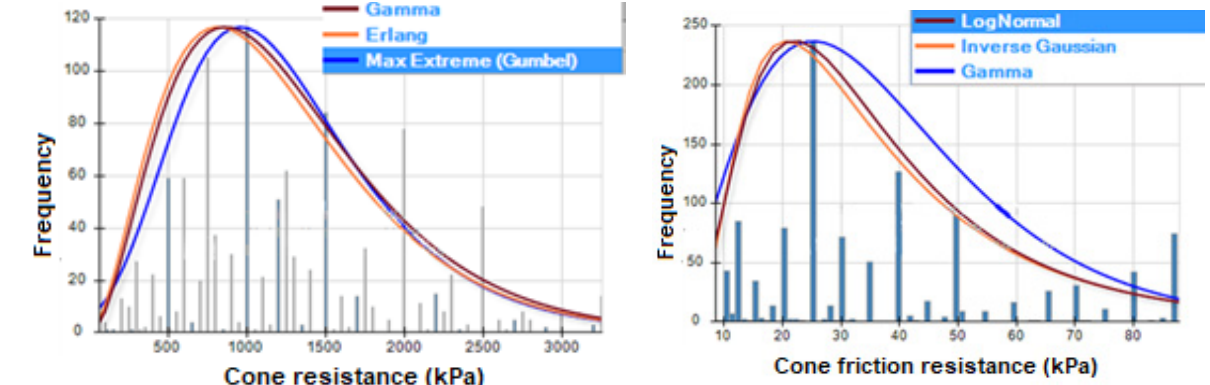
Figure 9. Adequate theoretical functions for the distribution of advanced resistance and friction data from the CPT trial.